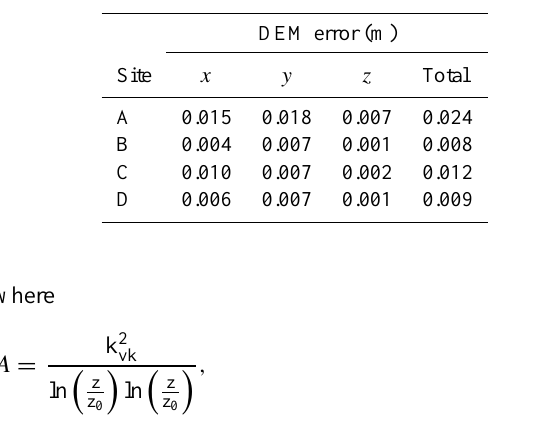
Table 2. Errors associated with the DEM for each